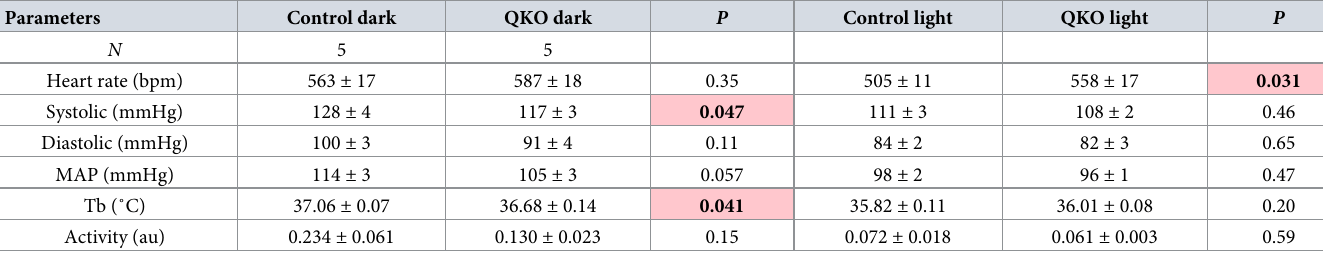
Table 3. Baseline cardiovascular parameters in QKO and control